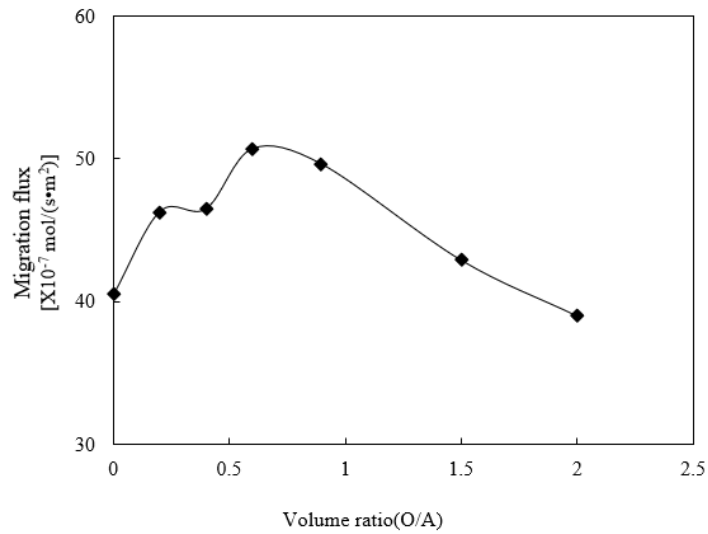
Figure 9. Effect of volume ratio of organophosphonic liquid to acid liquid (O/A).